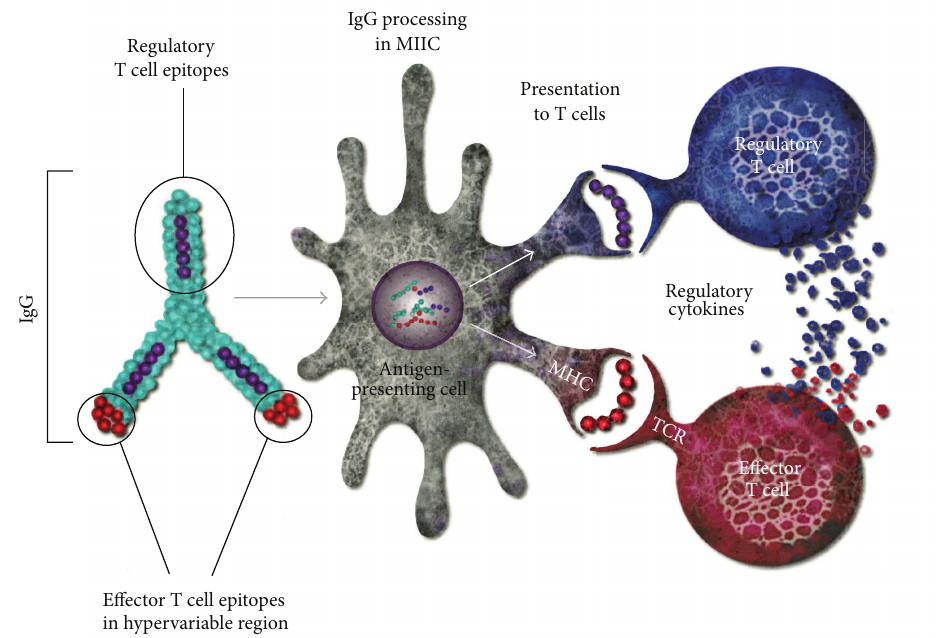
Figure 1: Postulated Tregitope mechanism of action. Tregitopes are highly conserved Treg epitopes found in human and other species’ IgG. They are postulated to reduce the immunogenicity of neo-epitopes in the hypervariable region of IgG CDR; they also suppress immune response to other co-delivered T cell epitopes. (A version of this figure was originally published in Blood. De Groot A. S., Moise L., McMurry J. A., Wambre E., Van Overvelt L., Moingeon P., Scott W., Martin W. Activation of natural regulatory T cells by IgG Fc-derived peptide “Tregitopes”. Blood 2008; 112: